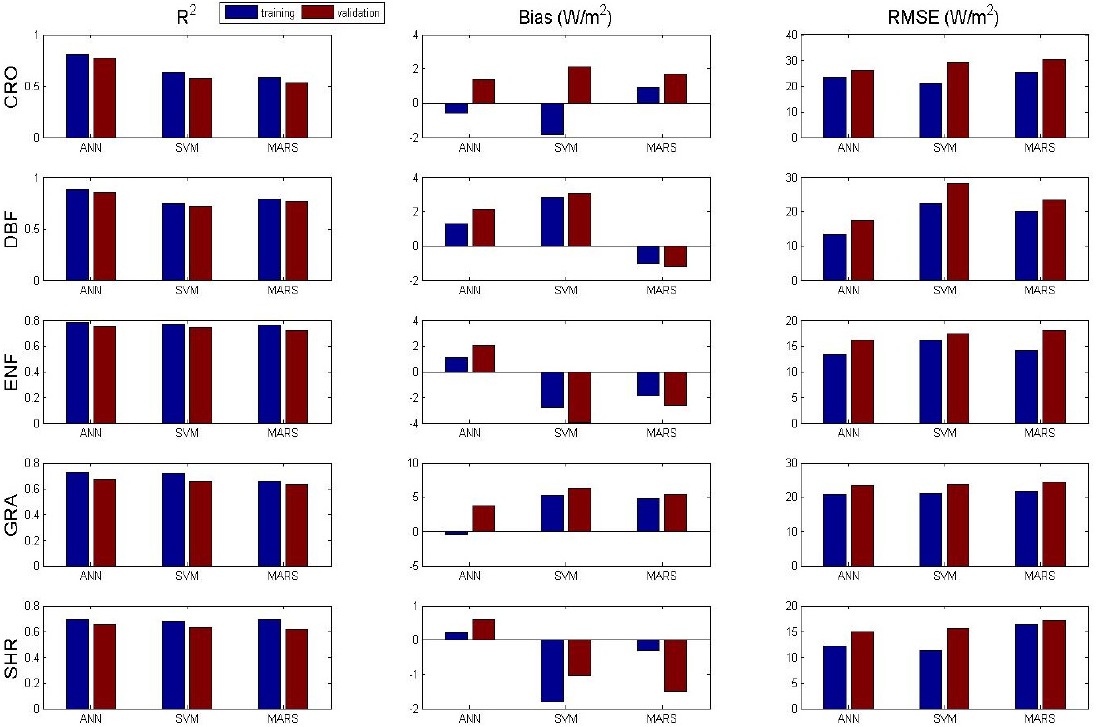
Figure 7. Bar graphs of the training and validation statistics ( R 2 , Bias and RMSE) of three algorithms driven by MERRA meteorology for five PFTs at the 85 flux tower sites. All of the R 2 values are significant with a 99% confidence.